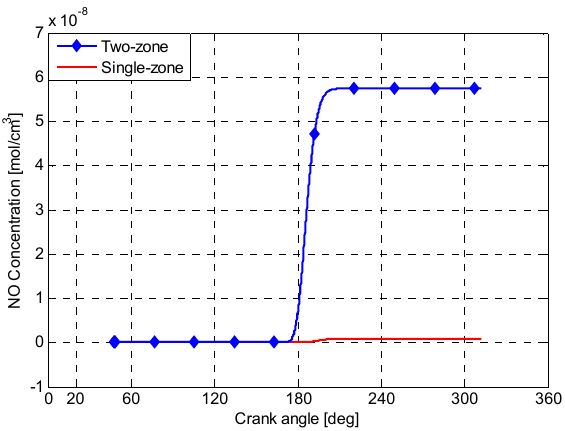
Figure 10. NO concentration in two-zone model and single-zone model.